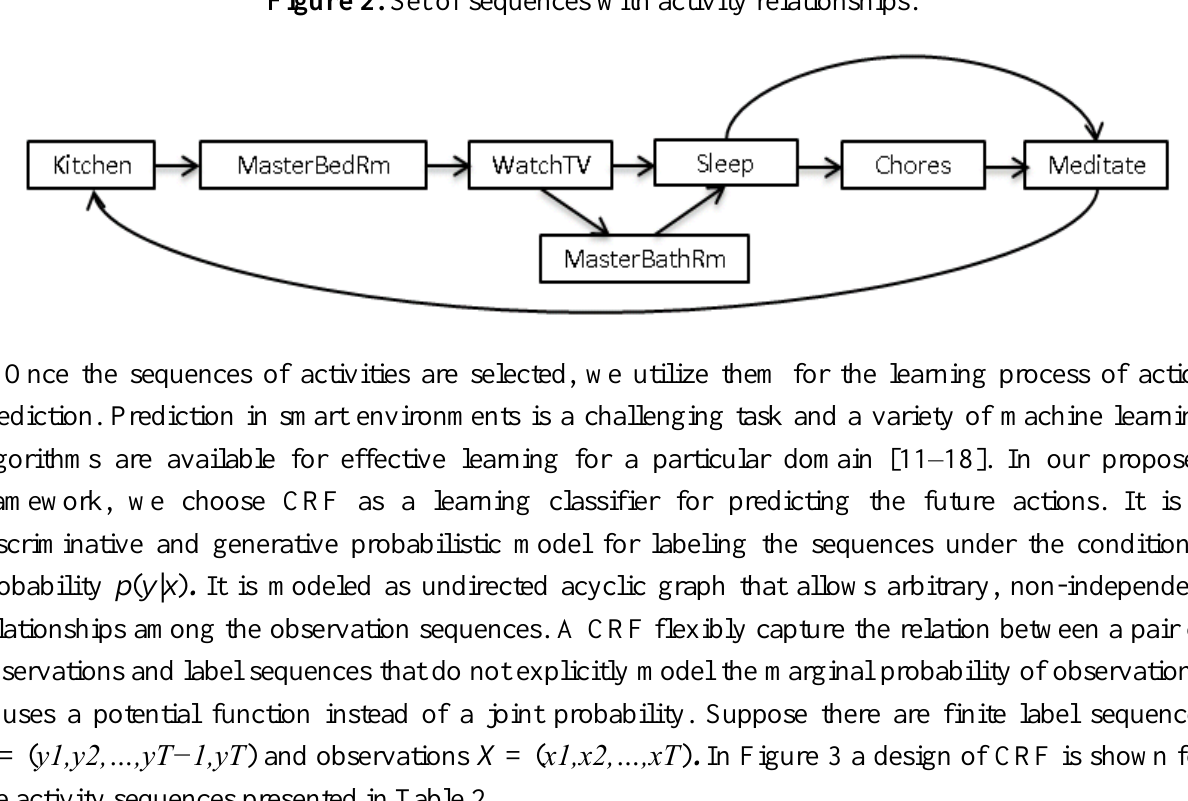
Figure 2. Set of sequences with activity relationships.